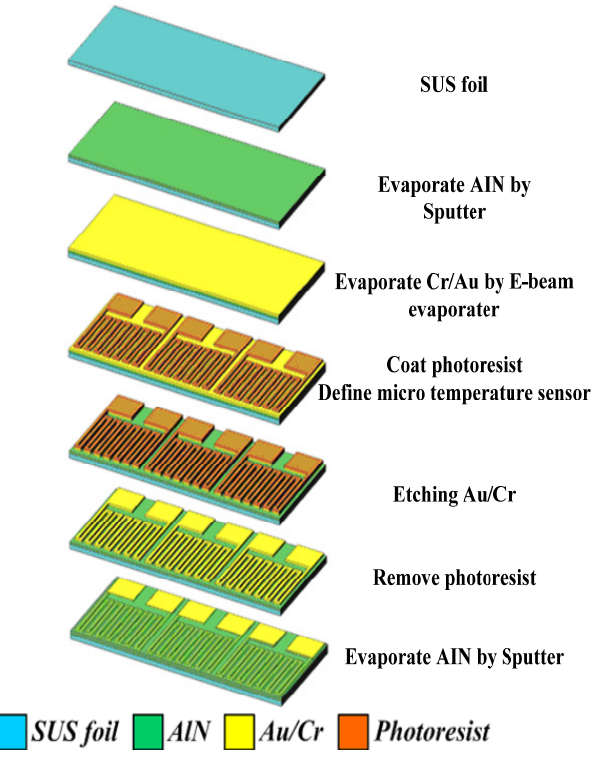
Figure 1. Flowchart of the micro temperature sensor